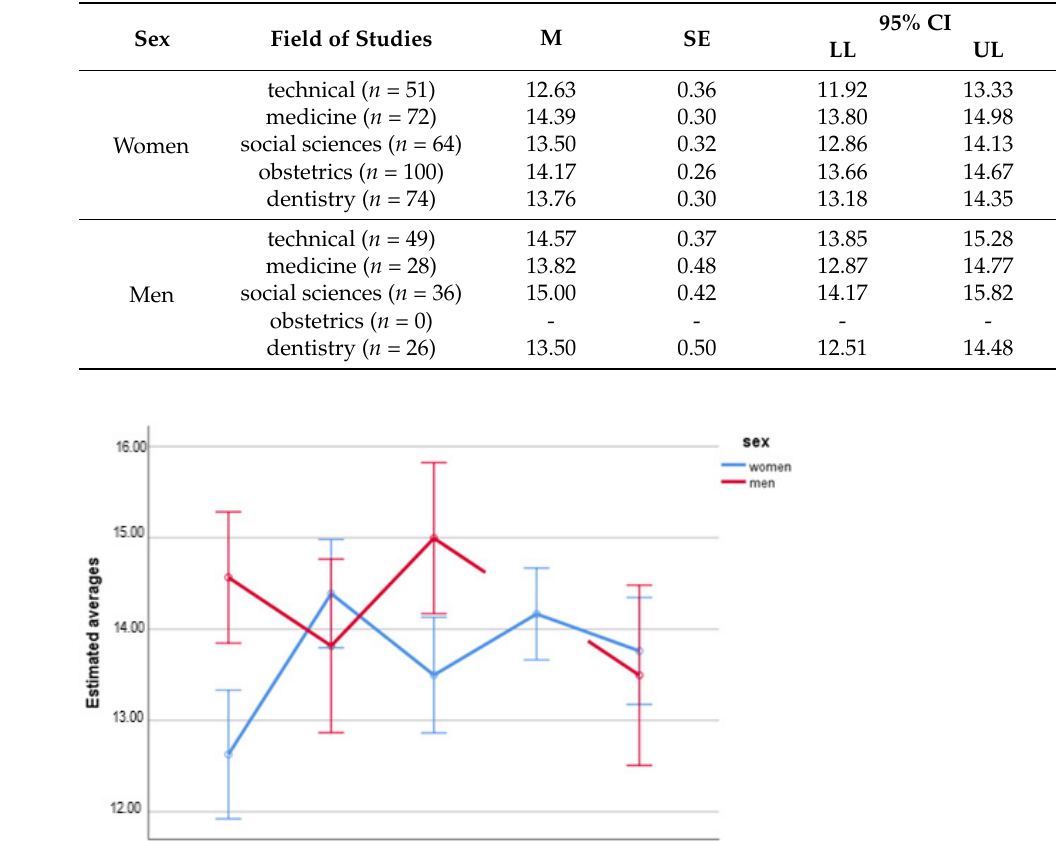
Table 3. Descriptive statistics for somatic domain with regard to sex and field of the studies.